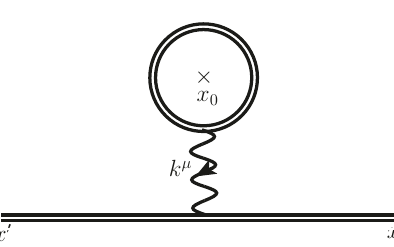
Figure 3 . The 1PR contribution to the particle self-energy, where a tadpoles is sewn to the propagator (shown in position space; x 0 is the centre of mass of the loop.). The double lines indicate the particle propagators dressed to all orders by the background